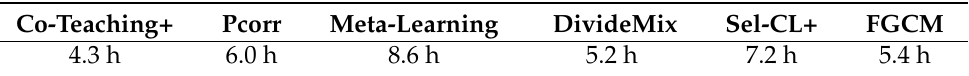
Table 9. Comparison of total Training Time on CIFAR-10 with 50% symmetrical label noise, using a single Nvidia Telsa V100